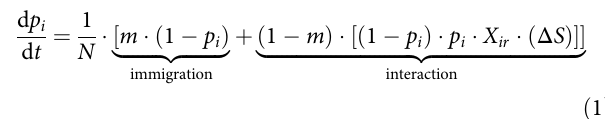
¼ 1 : 0), type R goes extinct. Above i